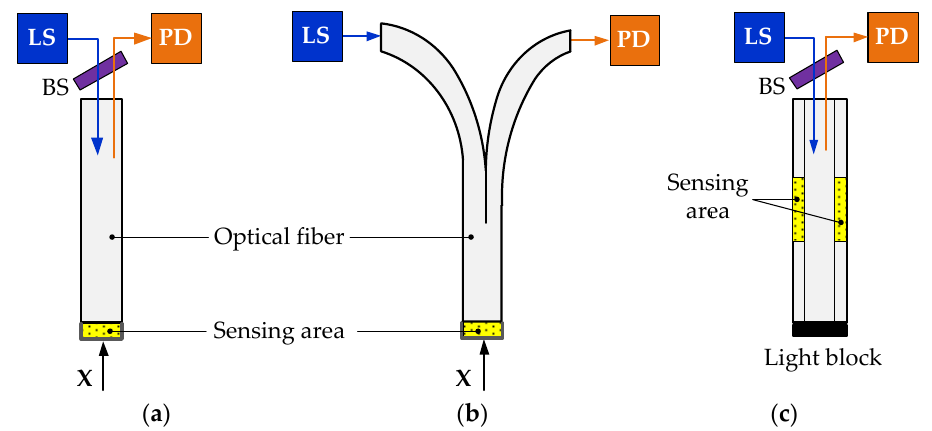
Figure 4. Typical schemes used for chemical sensors and biosensors: ( a ) single fiber (or bundle); ( b ) bifurcated optical fiber sensor; ( c ) evanescent wave sensor. LS = light source; PD = photodetector, BS = beam splitter; X = parameter of interest.